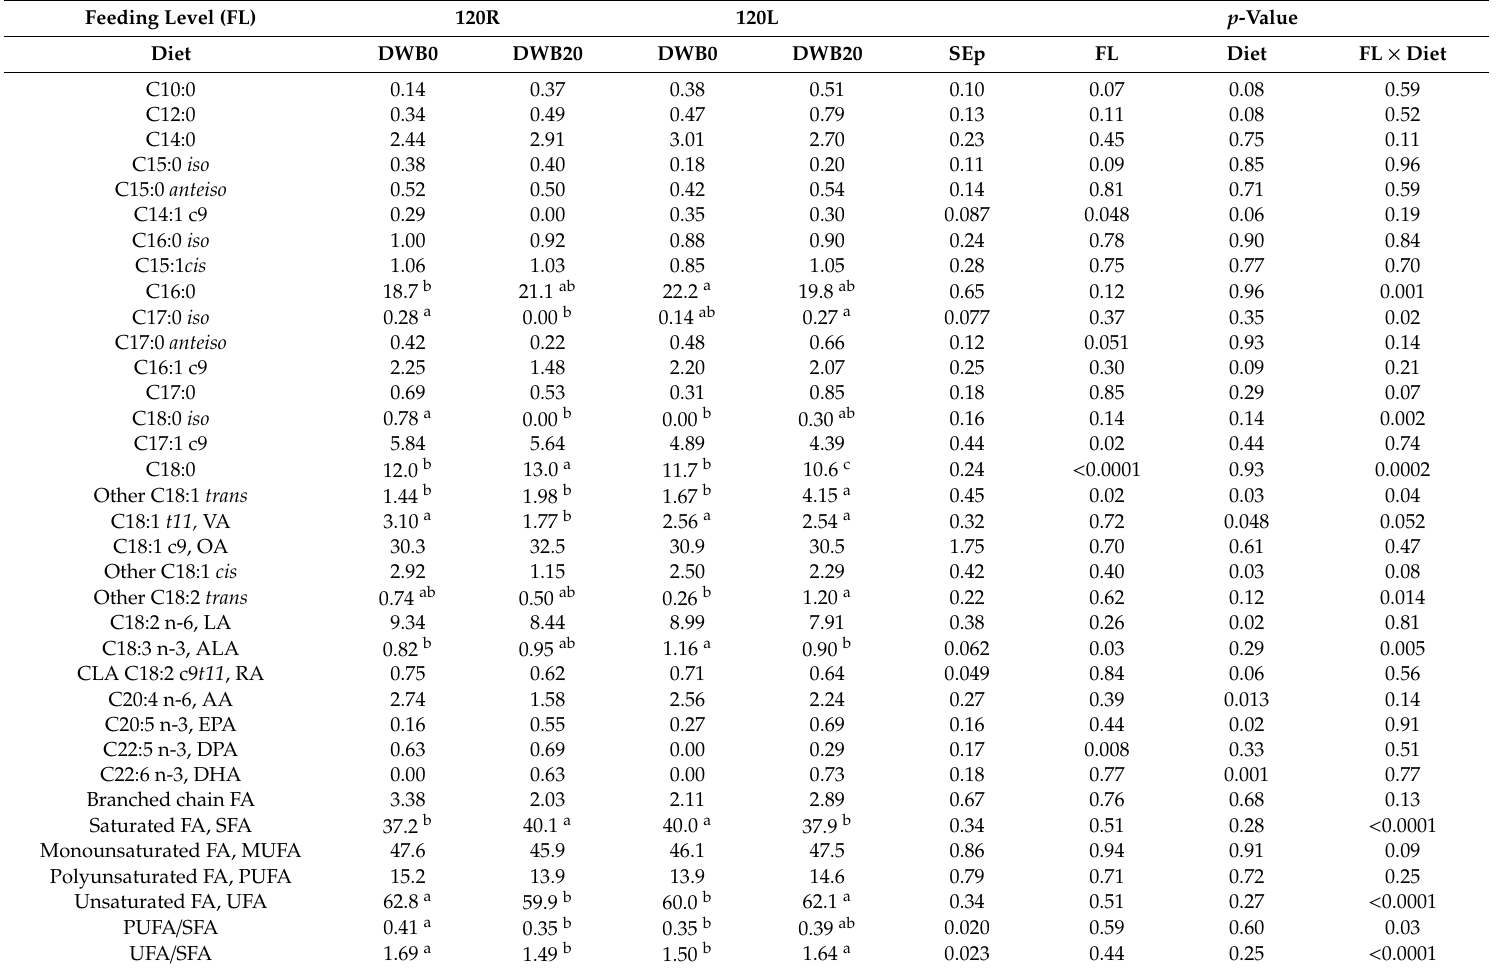
Table 6. Fatty acid composition (g / 100 g FA) of LD meat from 120-day-old male